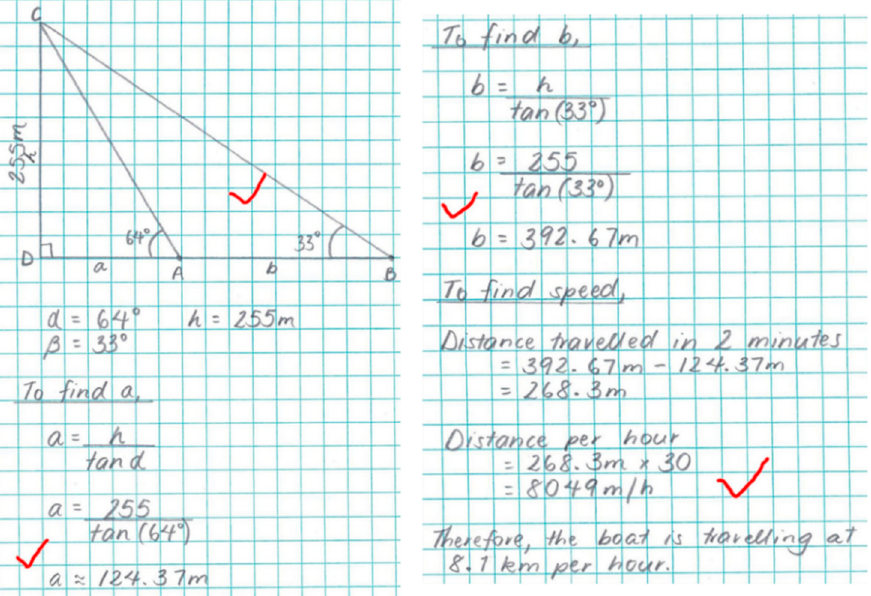
Figure 3. Recaptured student’s work correctly solved the first problem by right triangles. Table 4. Effect of different strategies on the performances in solving the first word problem.